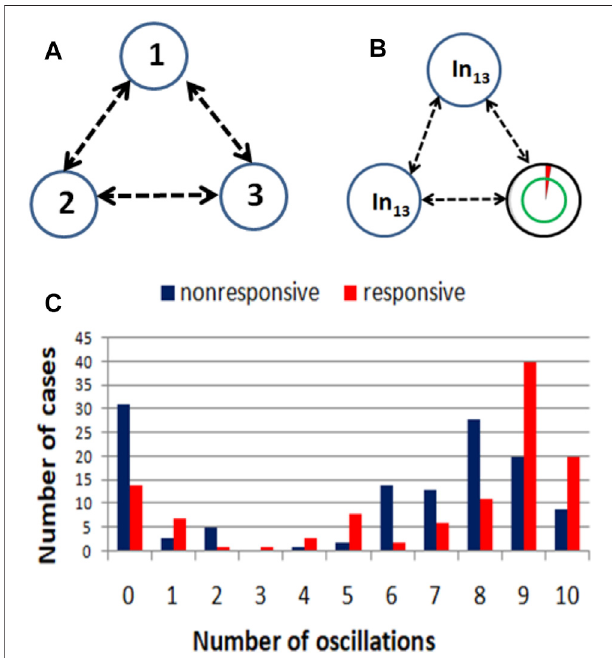
FIGURE 4 | (A) An example illustrating the idea of a computing oscillator network. (B) The structure a network that produces a high correlation between the RPS7 gene expression and the result of drug therapy. The symbol In 13 marks input oscillators. The rightmost oscillator is a normal one, and it is also the output oscillator what is indicated with a double circle. (C) Correlations between the success of therapy and the number of activator maxima observed on the output